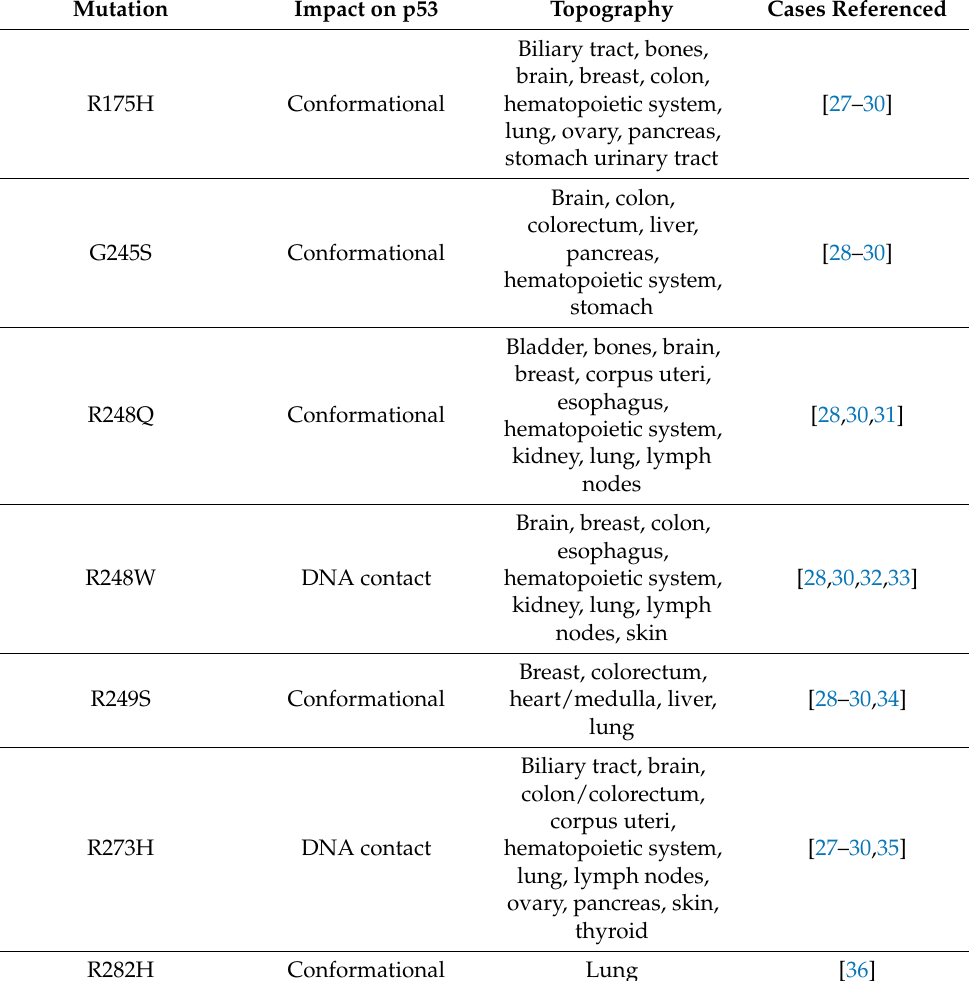
Table 1. Clinical relevance of documented p53 hotpots mutations that affect protein conformation or DNA contacts. Mutation R175H has been found in tumors within the biliary tract, bone, brain, breast, colon/colorectum, hematopoietic system, lung, ovary, pancreas, and stomach [27–30]. Mutation G245S has been found in brain, colon/colorectum, hematopoietic system, kidney, liver, pancreas, and stomach tumors [28–30]. The R248Q mutation occurs in bladder, bones, brain, breast, corpus uteri, esophagus, hematopoietic system, kidney, lung, lymph nodes, pancreas, and stomach tumors [28,30,31]. The R248W mutation occurs in brain, breast, colon, esophagus, hematopoietic system, kidney, lung, lymph nodes, mouth, and skin tumors [28,30,32,33]. R249S has been documented in breast, colorectal, heart/medulla, liver, and lung tumors [28–30,34]. R273H has been found in the biliary tract, brain, colon/colorectum, corpus uteri, hematopoietic system, lung, lymph nodes, ovary, pancreas, skin, and thyroid tumors [27–30,35]. R282H is only documented in lung tumors [36]. Mutation Impact on p53 Topography Cases Referenced Biliary tract, R175H Conformational